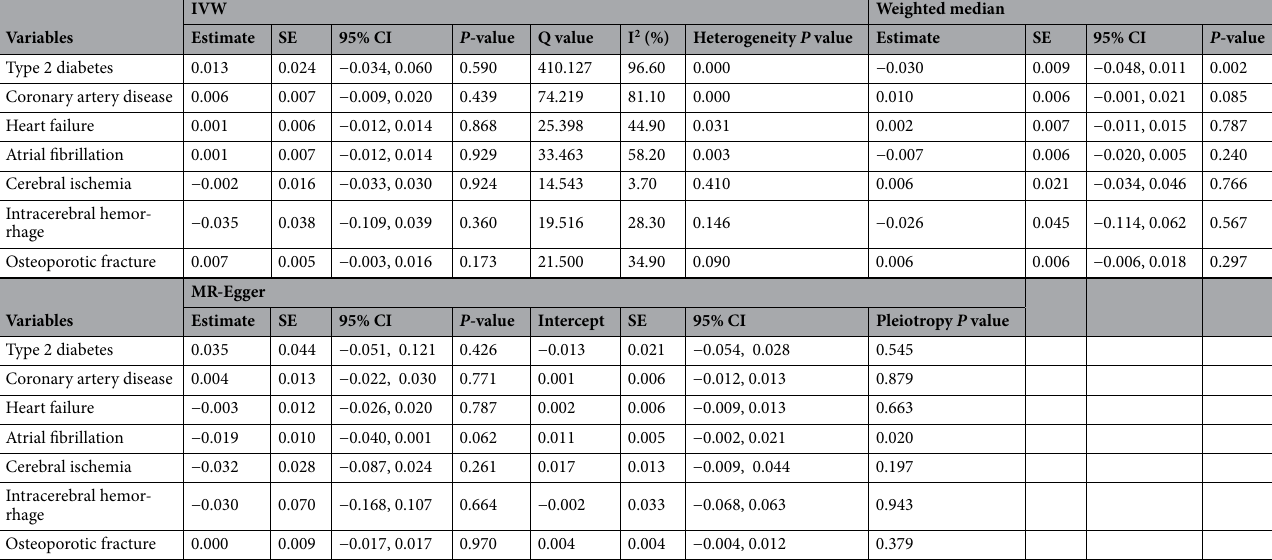
Table 2. Mendelian randomization estimates of adiponectin on outcomes. Q statistic represents a chi-square distribution with m-1 degrees of freedom under the null hypothesis of homogeneity. I 2 index is defined as the percentage of total variation in the estimates explained by heterogeneity. Heterogeneity p -value < 0.05 indicates significant heterogeneity, while pleiotropy p -value < 0.05 suggests the presence of pleiotropic SNPs.